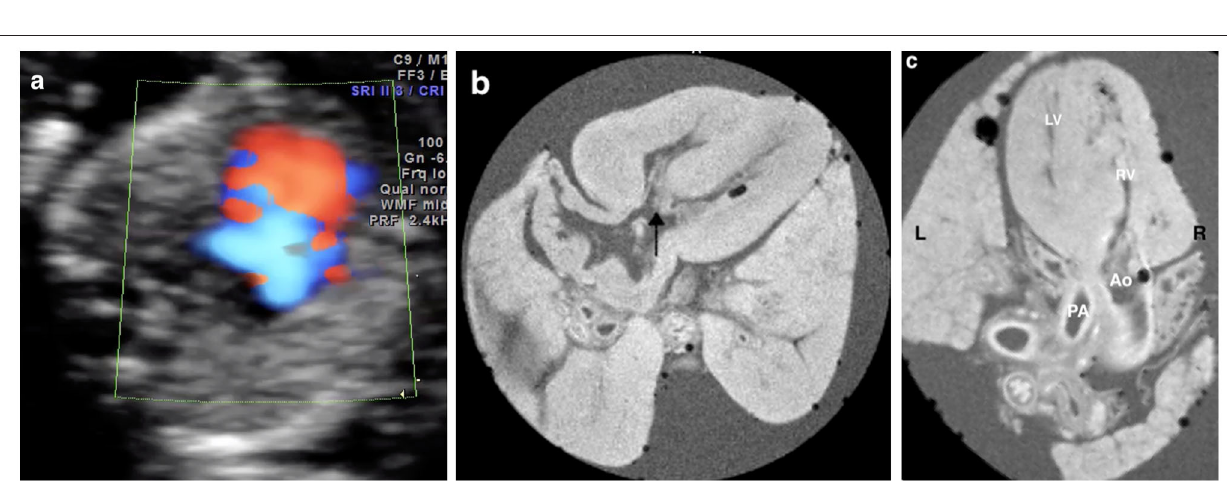
FIGURE 4 | Discordant findings of postmortem MRI and autopsy compared with prenatal ultrasound. (a) A fetus presented with severe tricuspid regurgitation on the color Doppler imaging in the first trimester and was terminated at 17 + 6 weeks of gestation for Trisomy 21 (Case 15 in Table 2 ); (b) Four-chamber view showed the atrioventricular septal defect (AVSD) (black arrow) on the postmortem MRI; (c) Microscopic evaluation (H&E) assessed the